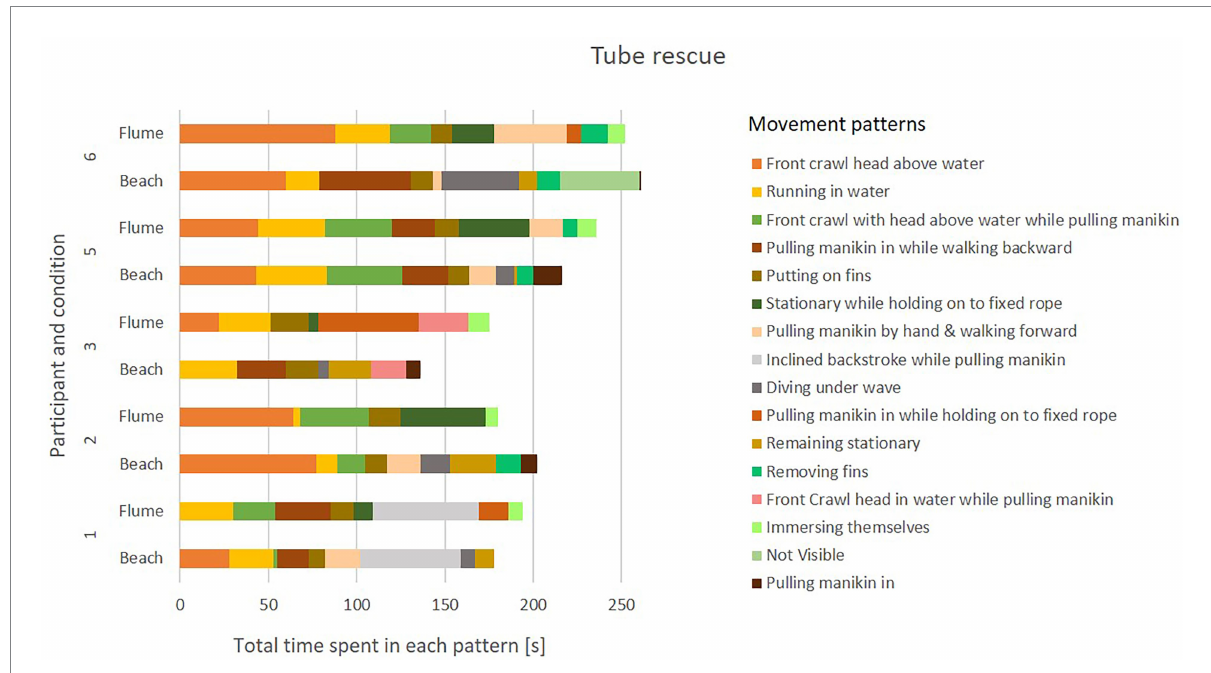
FIGURE 6 Movement patterns employed during tube rescue in ocean vs. flume conditions.